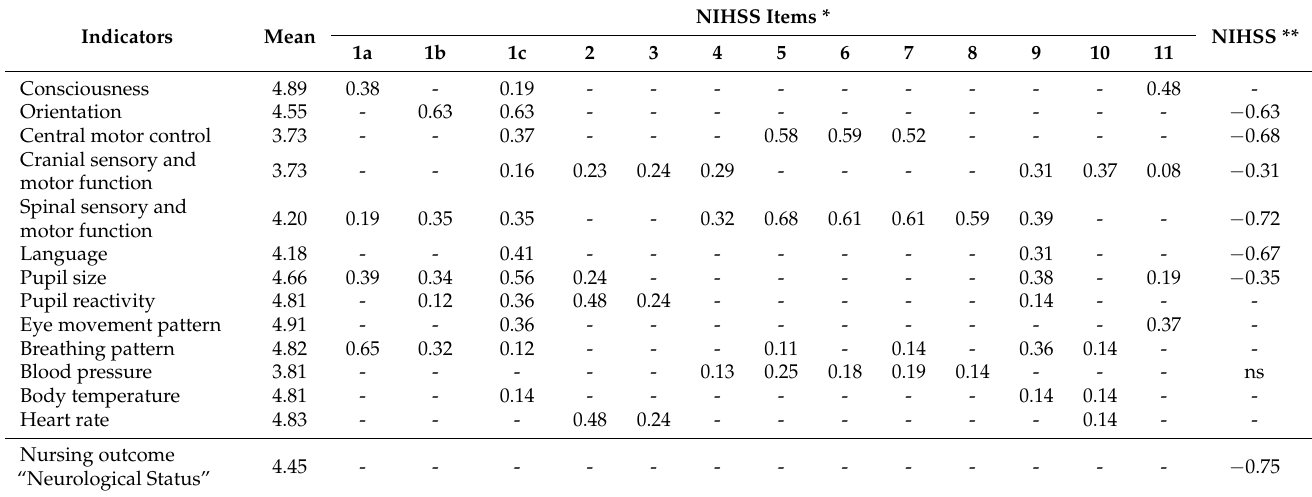
Table 3. Values of agreement and correlation between the indicators and the nursing outcome “Neurological Status” with the items and the total score of the National Institute of Health Stroke Scale.